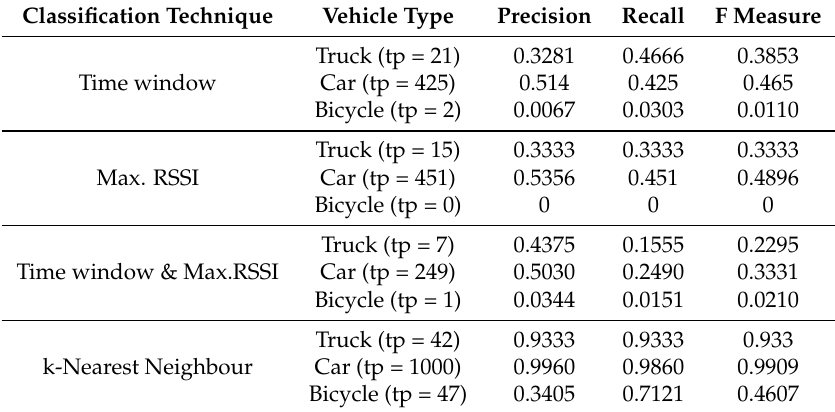
Table 7. Precision, Recall and F Measure using Steinfurter Straße data (tp indicates the number of true